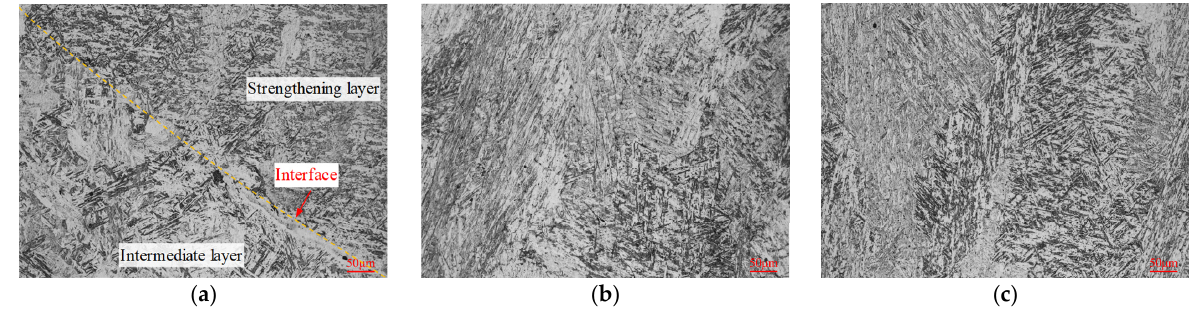
Figure 9. Microstructure of interface C. ( a ) Interface C (position 7). ( b ) Intermediate layer (position 8). ( c ) Strengthening layer (position 9).